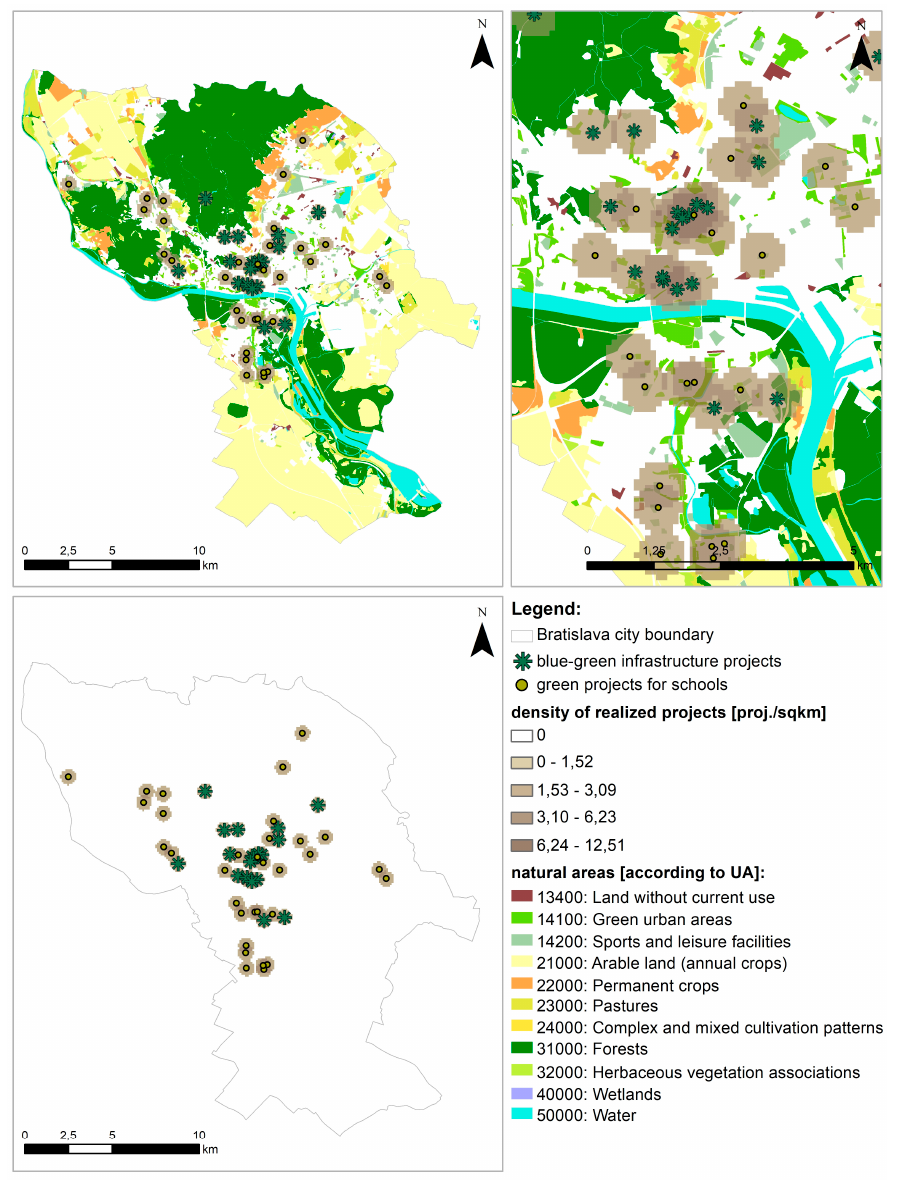
Figure 2. The green projects realized during period 2015–2018 in Bratislava. Top side of the figure shows the overview and density of projects regarding to natural areas in city (top-right figure shows the zoom to the city center). The lower section of the figure shows the overview and density map of projects [No. of projects per square kilometer]. Source: Own elaboration using ArcGIS